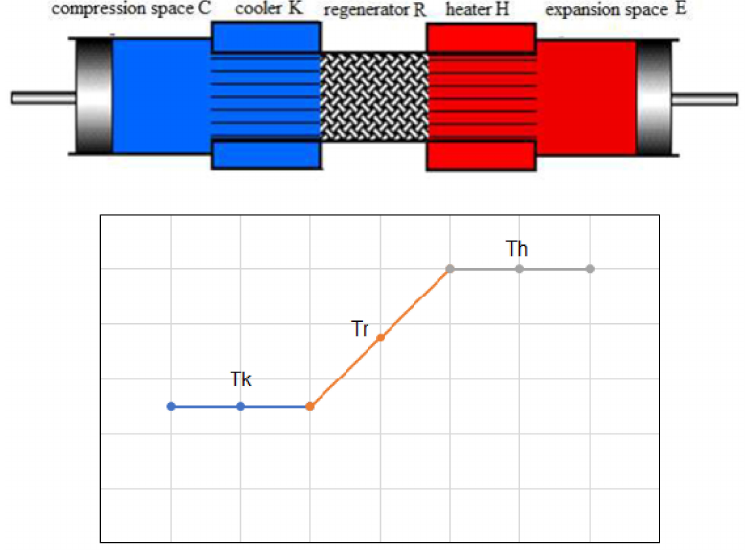
Figure 12. Temperature profile of the